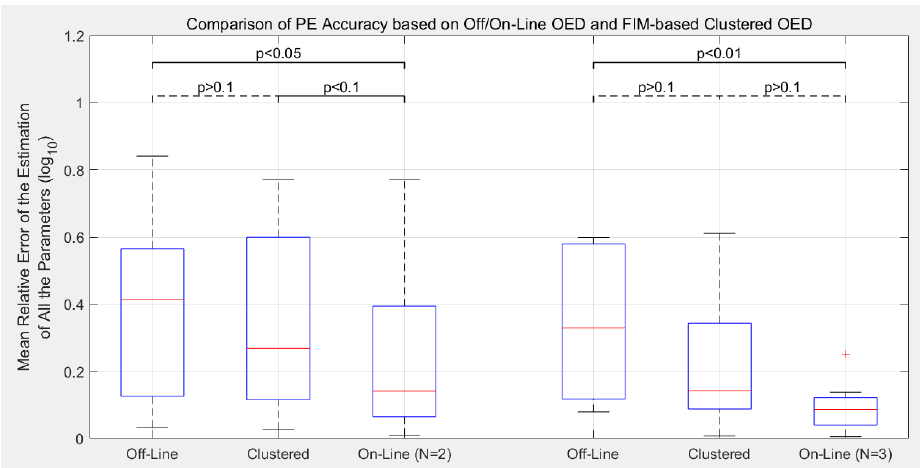
Figure 11. Comparison of the PE accuracy with off/on-line OED and FIM-base-clustered OED. p values stand for one-way t-test results. All the distributions pass the Kolmogorov-Smirnov normal- ity